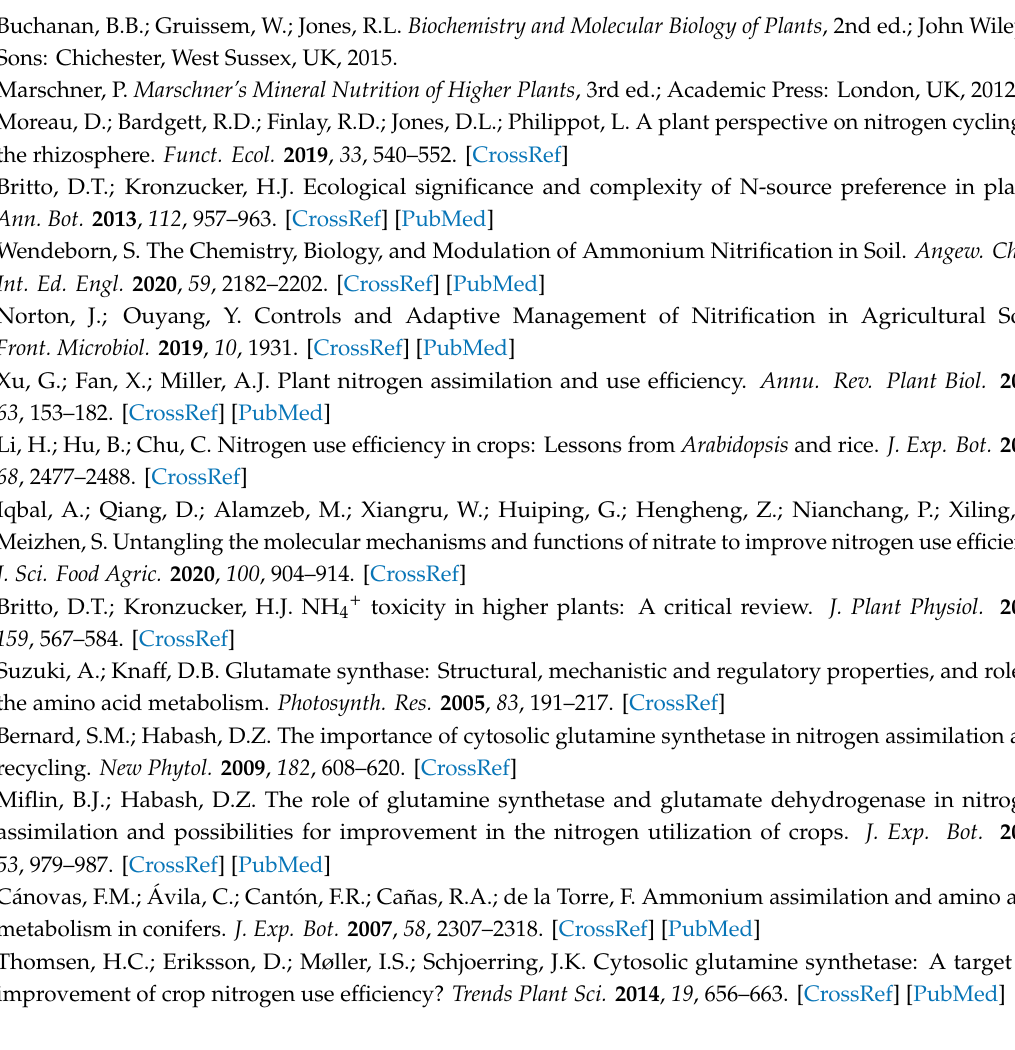
Figure S1: Heatmap of the metabolite profile data, Figure S2: L-Arginine amounts, Table S1: Metabolite profile results, Table S2: qPCR primer